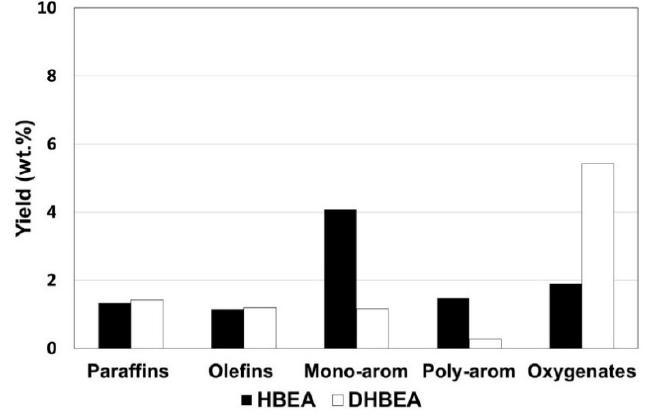
Figure 2. Yields of organic liquid products obtained by catalytic cracking of 30% DX/n-hexane from